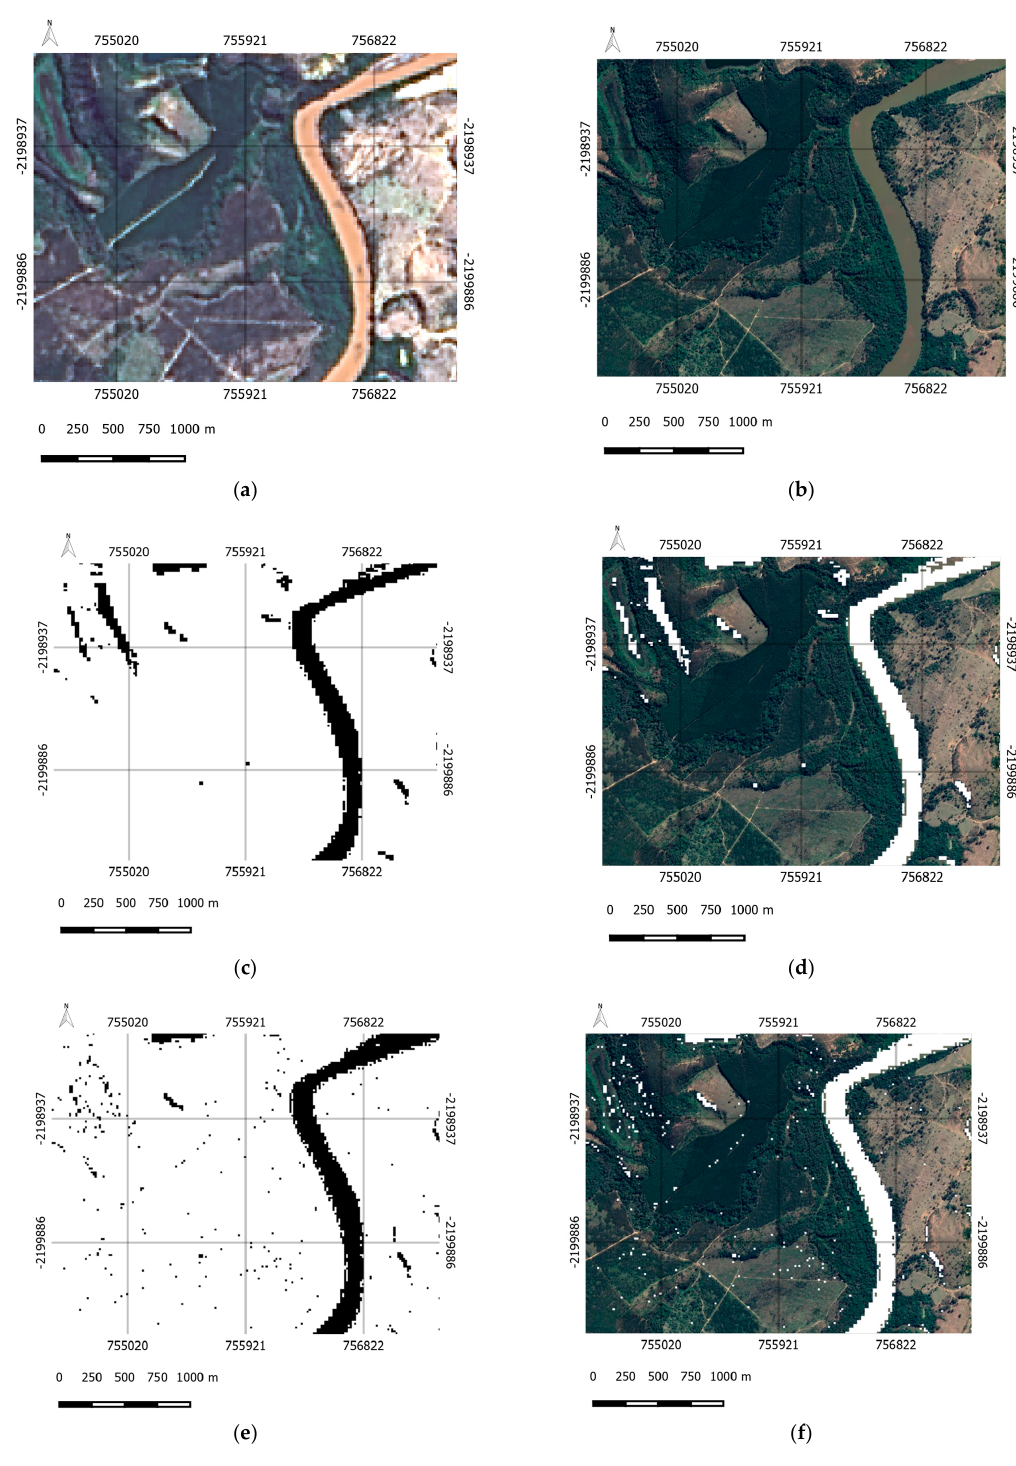
Figure 10. An example of the application of our strategy on an image tile taken from the image of the Doce River acquired by Landsat 8 in 2016: ( a ) enhanced image, in which there are two water bodies (the thick winding river and a narrow lake on the top); ( b ) the real image; ( c ) contextual classifier (boost) output; ( d ) result overlay of ( c ) (white) on the real image; ( e ) non-contextual classifier (decision tree) output; ( f ) result overlay of ( e ) (white) on the real image. In ( c , e ), black and white represent pixels classified as water and no-water,